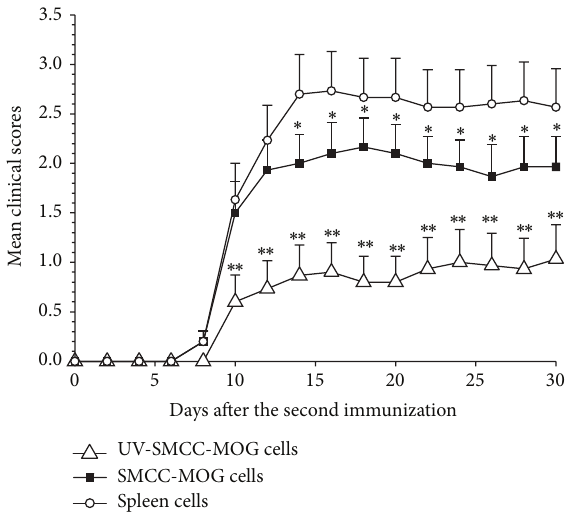
Figure 4: Adoptive transfer of CD4+ T cells leads to resistance to EAE induction. The splenic CD4+ T cells from three groups (treatment of SPs, UV-MOG-SPs, or MOG-SPs) were intravenously injected into na¨ıve C57BL/6 mice (5 mice/group), respectively. After receiving CD4+ T cell transfer, all recipient mice underwent EAE induction on the same day. EAE development was monitored daily for 30 days. The scores of UV-MOG-SPs or MOG-SPs group were compared with the scores of SPs group at each time point. ∗ 𝑝 < 0.05 ; ∗∗ 𝑝 < 0.01 . Similar data were obtained from two additional independent experiments, and the donor cells were prepared from different mice in these three